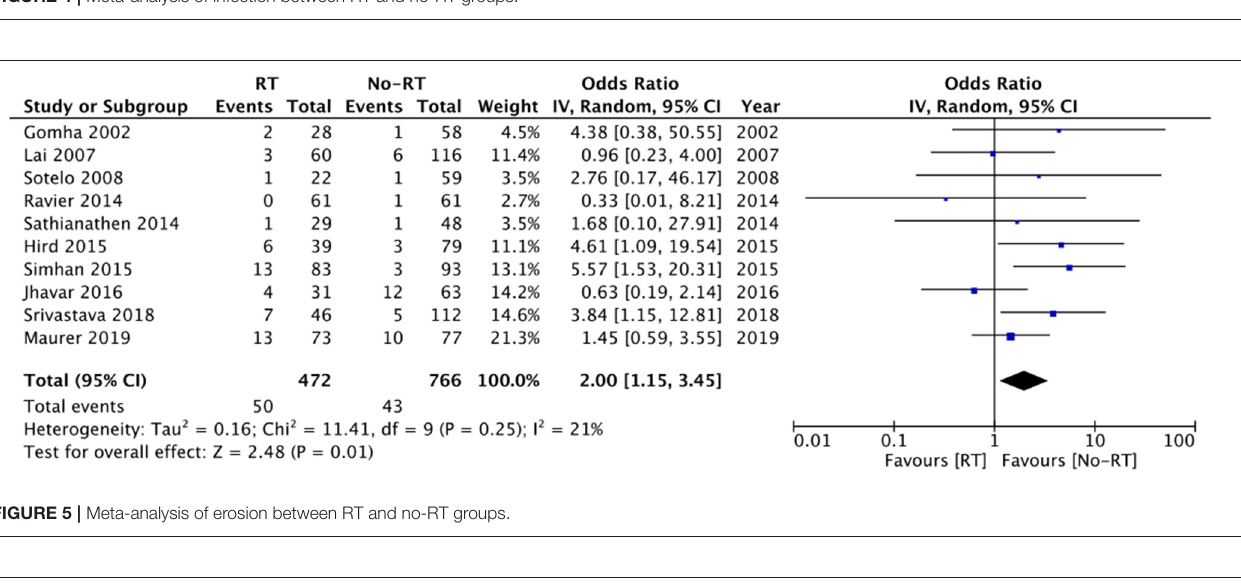
FIGURE 4 | Meta-analysis of infection between RT and no-RT groups.